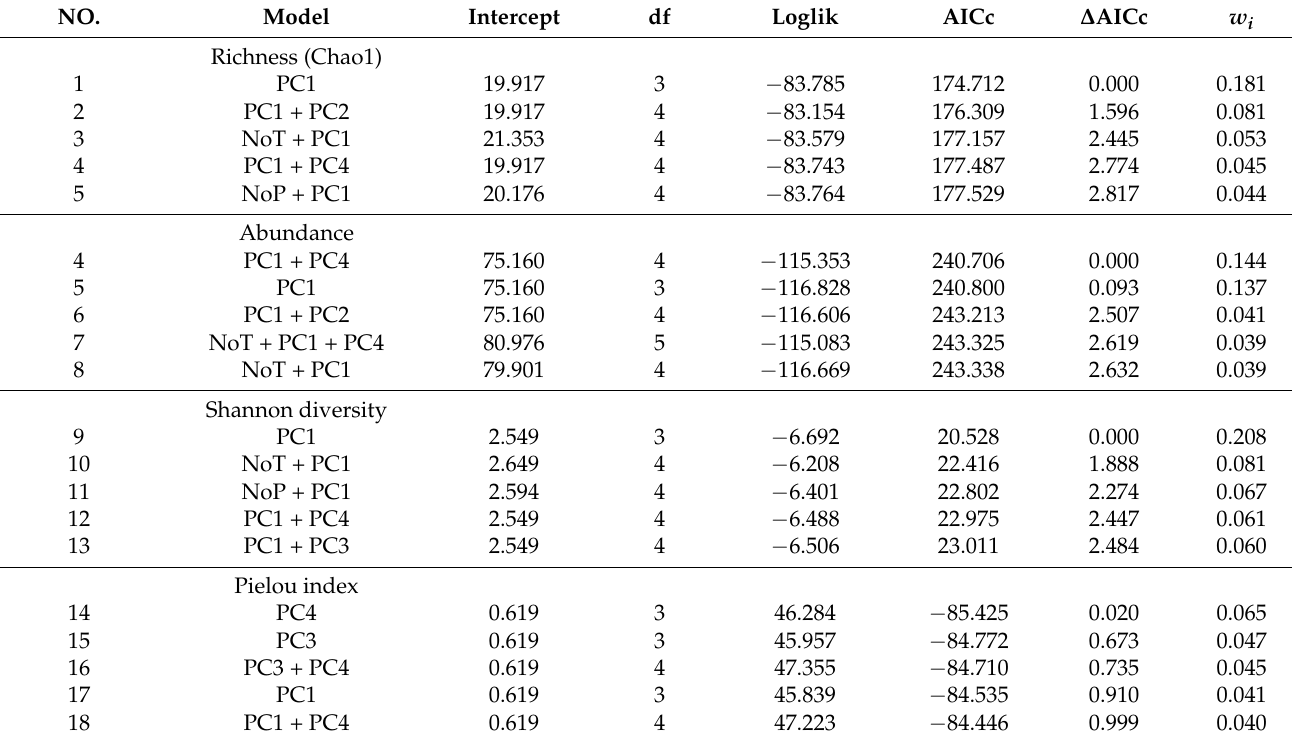
Table 2. A multiple linear regression model based on the relationship between simulated bird diversity (predictor variables) and vegetation habitat variables (response variables) under the Akaike information